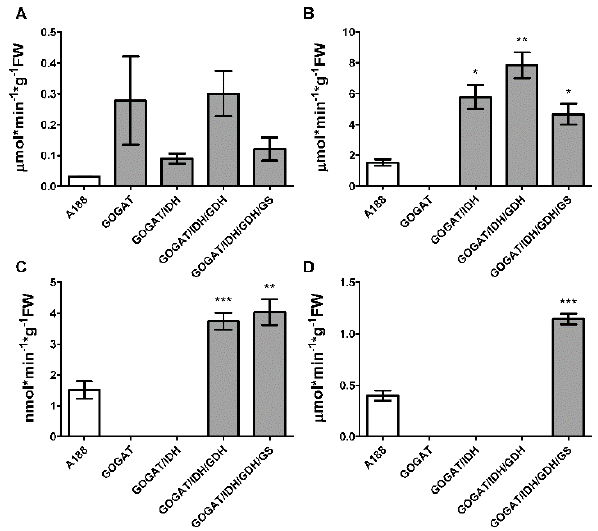
Figure 1. Enzyme activities of control and transgenic plants modified for 2-Oxoglutarate production and ammonium assimilation. The white column corresponds to the WT plants (A188). The grey columns correspond to transgenic line overexpressing NADH-GOGAT (construct T02291) and NADH-GOGAT stacked with NAD-IDH (construct T02289), NAD-IDH + NADH-GDH1 (construct T02308) and NAD-IDH + NADH-GDH1 + GS1.3 (construct T02312). NADH-GOGAT, ( A ). NAD-IDH, ( B ). NADH-GDH, ( C ). GS1.3, ( D ). The error bars correspond to the standard error (SE). Data were * at p ≤ 0.05; ** at p ≤ 0.01, *** at p ≤